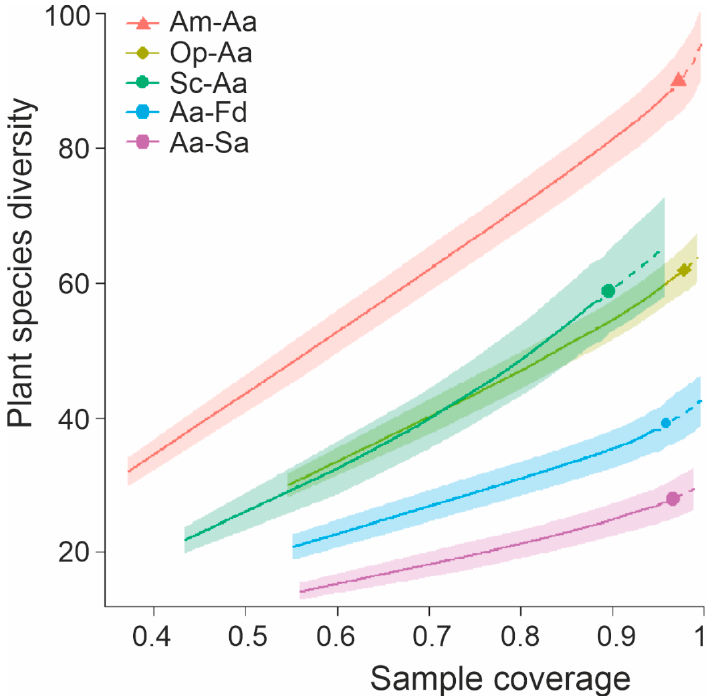
Figure 6. Sample coverage-based, rarefaction (solid) and extrapolated (dashed) curves of Shannon true diversity, along with their 95% bootstrap envelopes, corresponding to five community types (co)dominated by Artemisia alba . Abbreviations as in Figure 2.